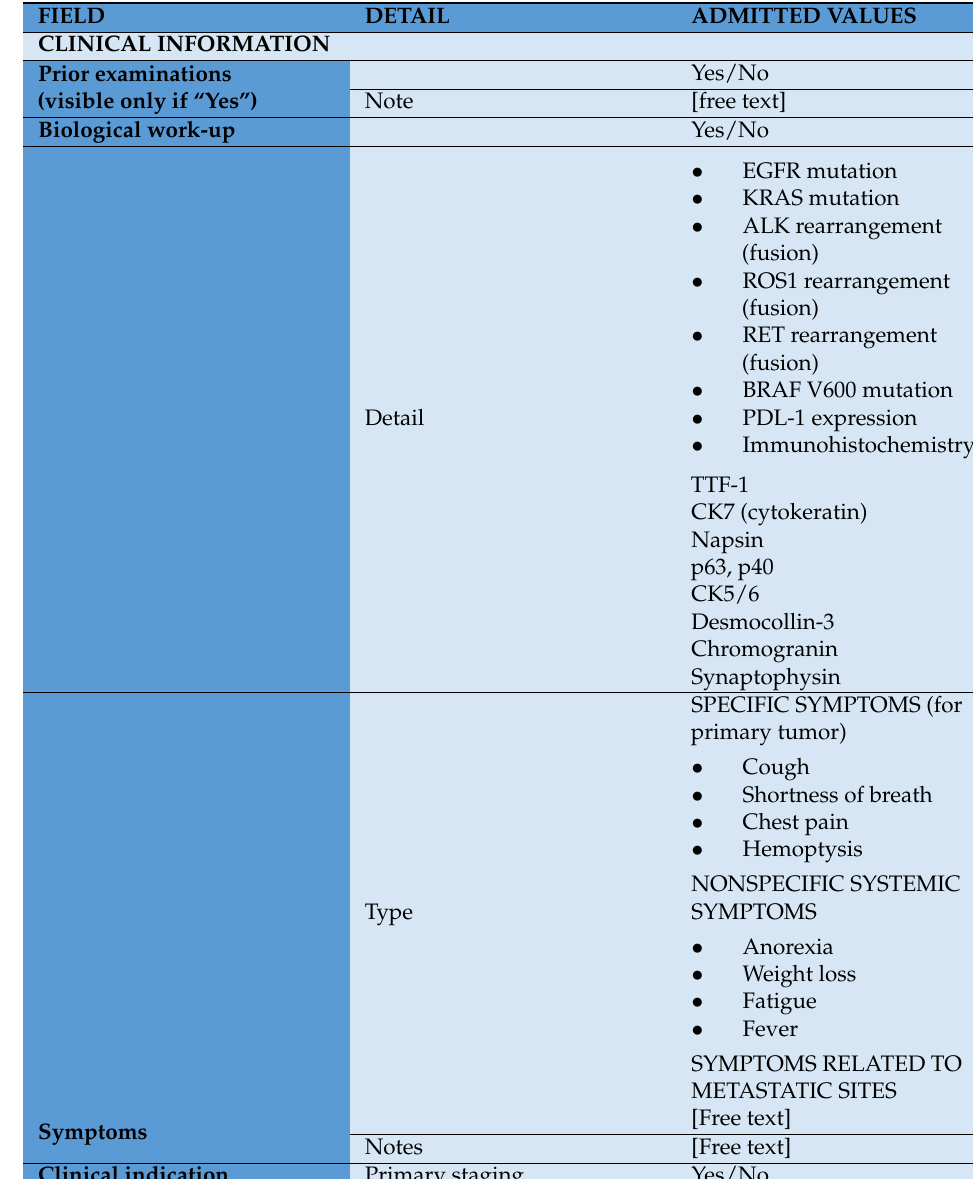
Table A3. Clinical